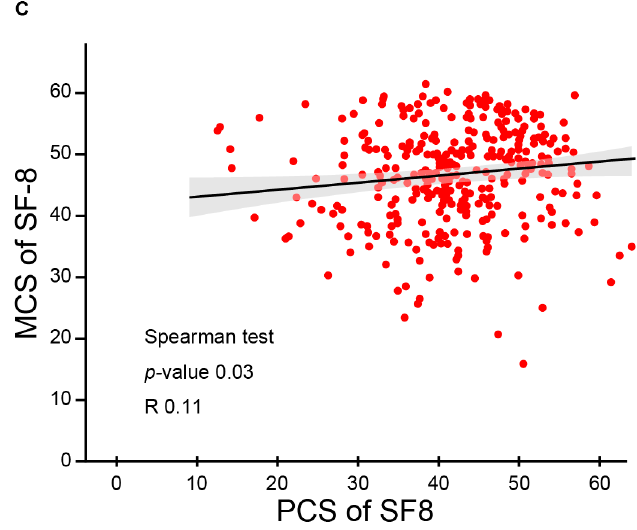
Figure 3. Scatter plots for MSTS scores and PCS and MCS of SF-8 are shown. Correlation estimates were generated and regression lines were drawn. The scores at all follow-up points were plotted. ( A ) MSTS scores were positively correlated with the PCS of SF-8. ( B ) MSTS scores were weakly positively correlated with the MCS of SF-8. ( C ) The PCS and MCS of SF-8 showed a weak positive correlation.